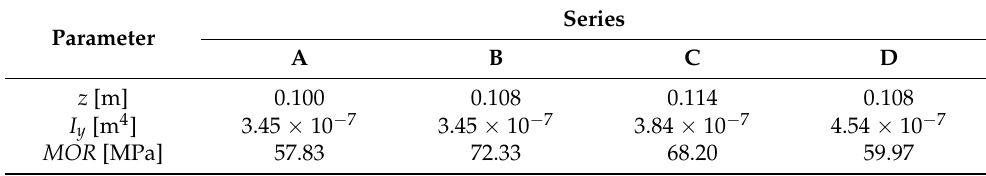
Table 10. Analytical analysis